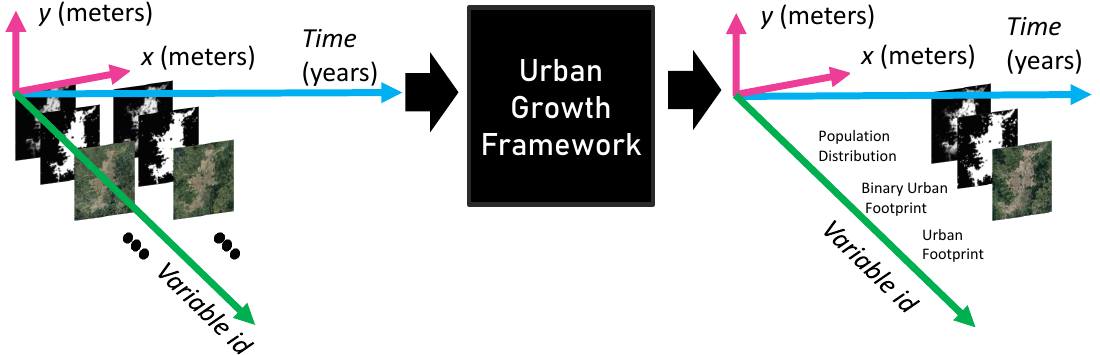
Figure 1. The urban growth framework predicts population distribution, binary urban footprint, and urban footprint in color from these and other spatially distributed variables, if they are